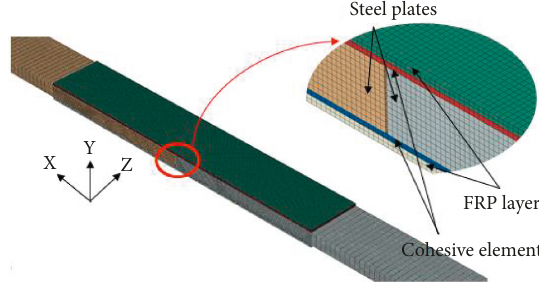
Figure 2: Typical FE mesh for FRP-steel double strap joints (full- size specimen).